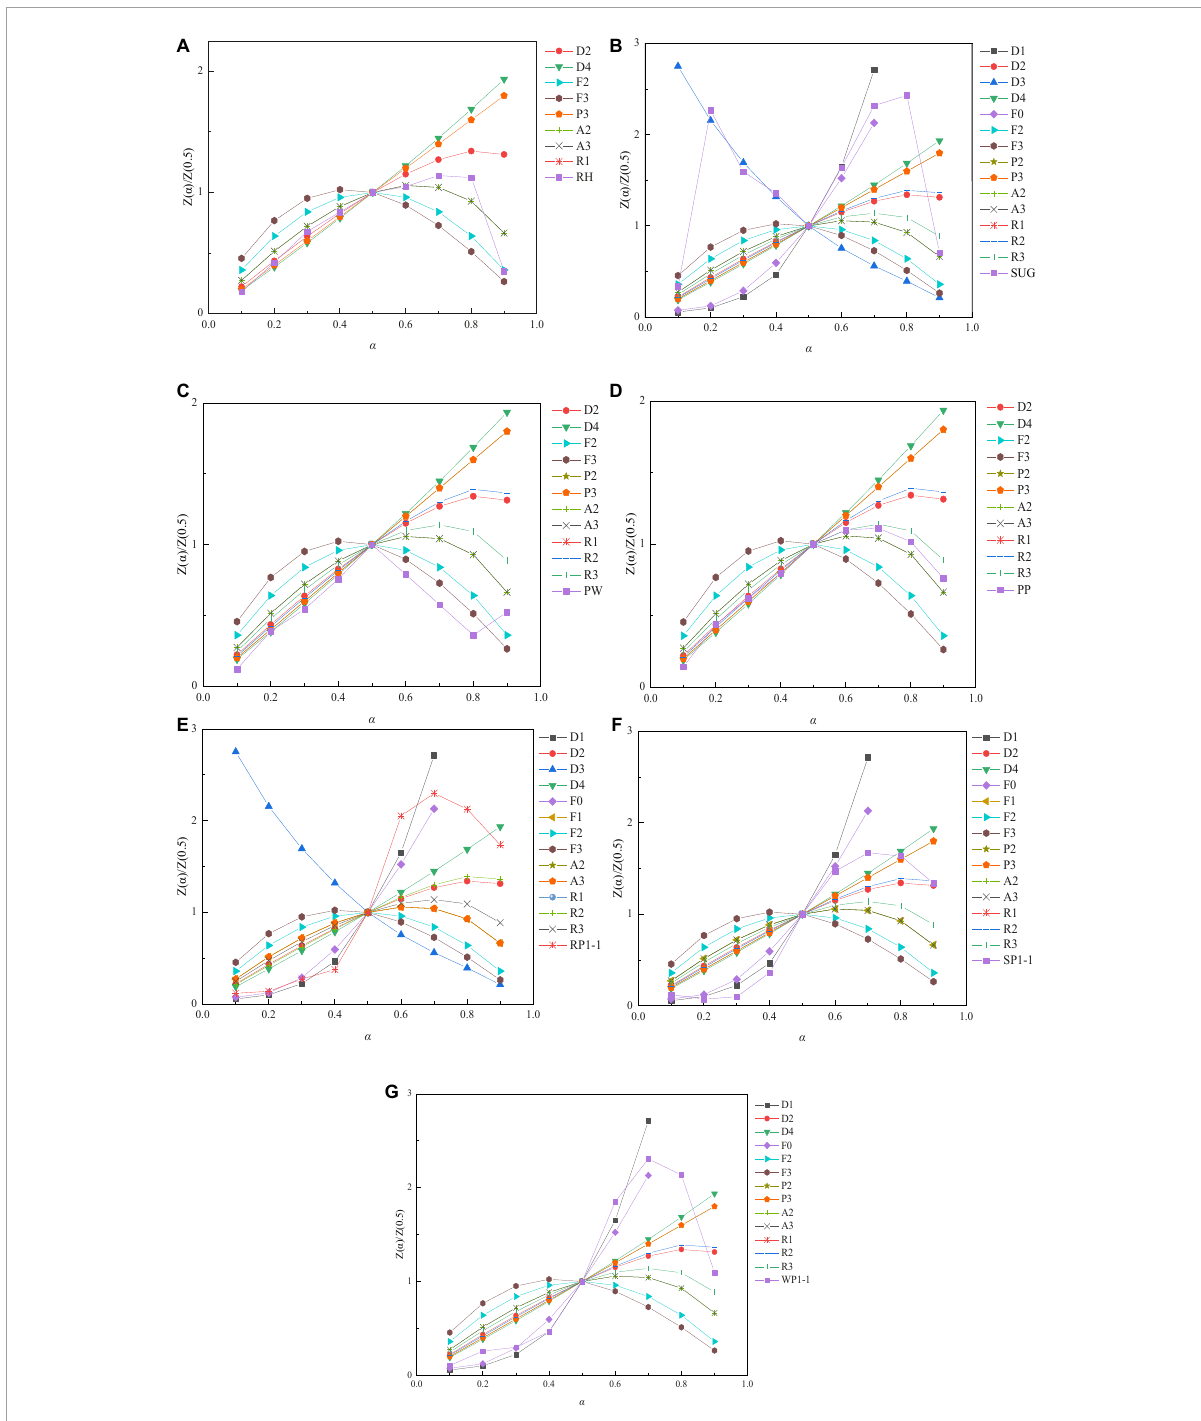
FIGURE7 Theoretical and experimental plots for prediction of solid-state reaction mechanism by Criado method (Z-master plot): (A) RH, (B) SUG, (C) PW, (D) PP, (E) RP1-1, (F) SP1-1, and (G) WP1-1.